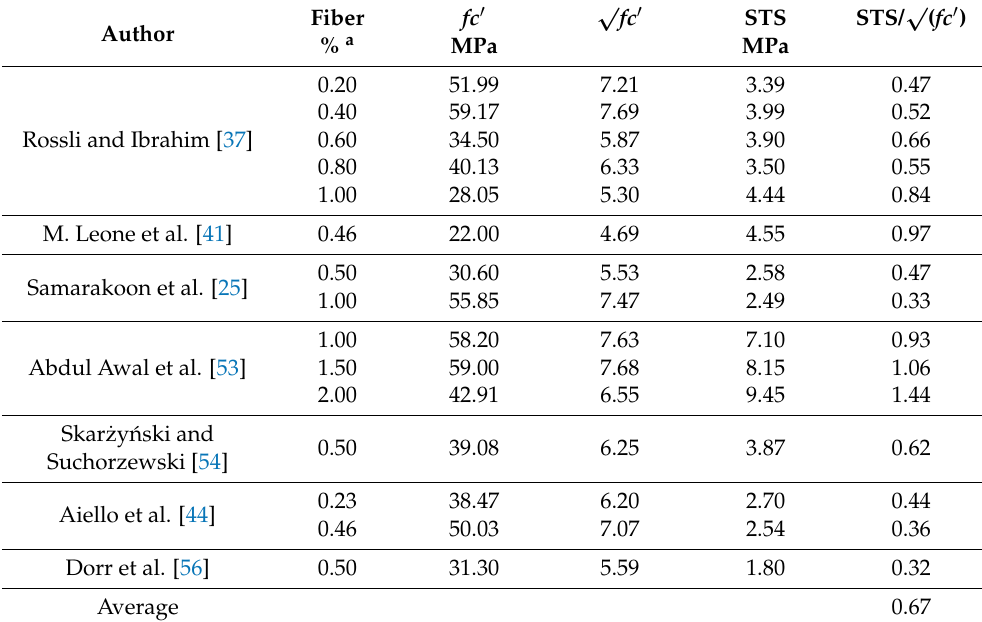
Table 14. The ratio between compressive strength and split tensile strength for RSF concrete.